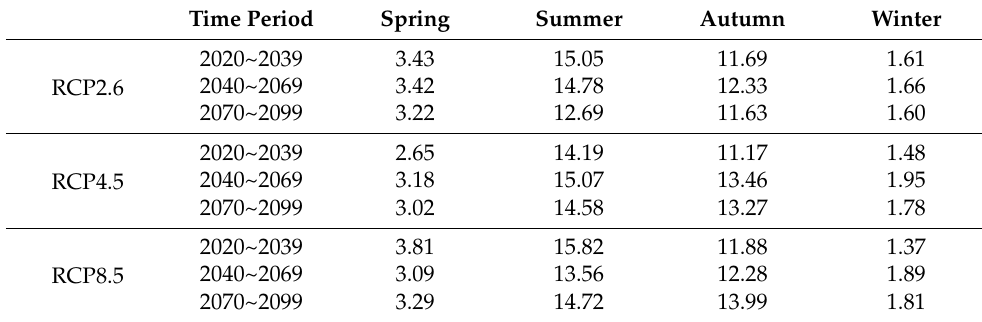
Table 6. The seasonal changes in runoff under different scenarios (unit: 10 8 m 3